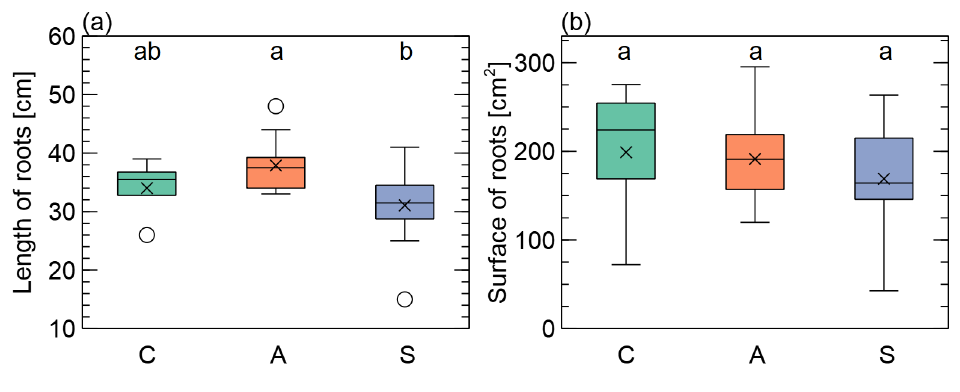
Figure 7. Length ( a ) and surface area ( b ) of roots of Scots pine seedlings. Three types of treatments were used: soil amendments with phosphogypsum mixed with organic ash—A, sewage sludge—S and control—C. The lowercase Latin characters above box plots, if the same, indicate that there is no statistically significant difference between the groups at p < 0.05. In the plot, boxes span from 1st to 3rd quantile, with the median indicated by a line, whiskers indicating 1.5 inter-quantile range, the × symbol mean value, and circles outlier